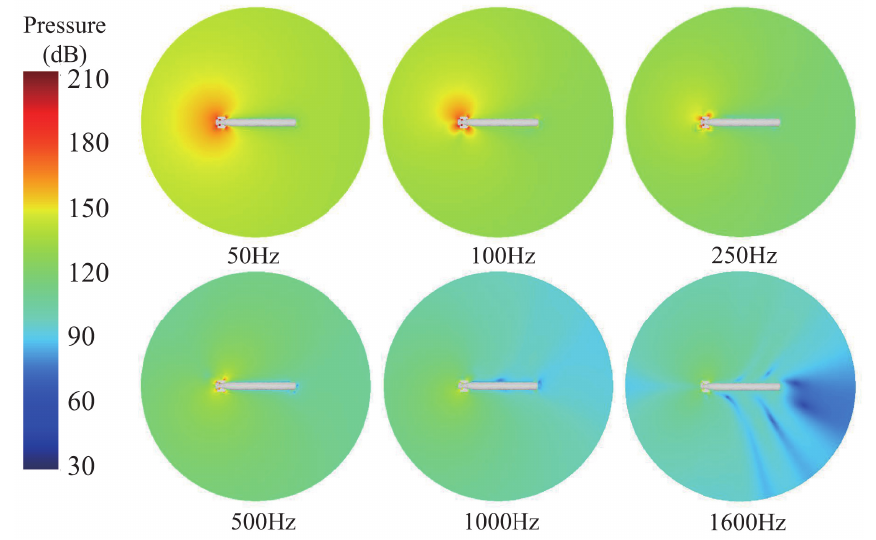
Figure 7. Sound pressure level distribution for pressure pulsation